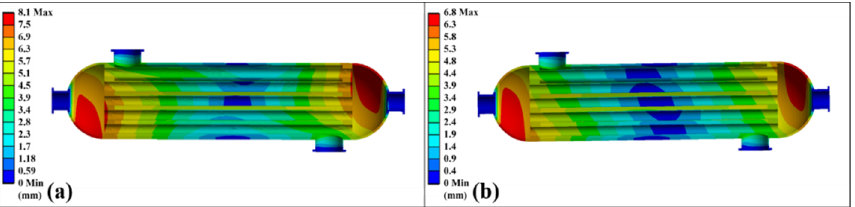
Figure 7. Distribution cloud map of superheater deformation variable when water vapor is located at different positions. ( a ) The water vapor on the shell side. ( b ) The water vapor on the tube side. Under stable operating conditions, when the molten salt and water vapor in the superheater are located at different positions, the inlet and outlet parameters of the heat transfer medium on the tube side and the shell side are summarized in Table